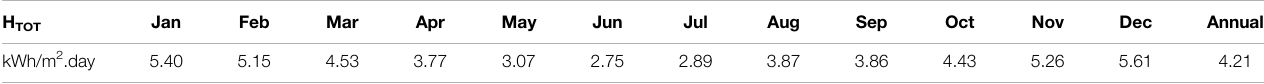
Data sources: elaborated from the Atlas data (Tiepolo et al., 2017).